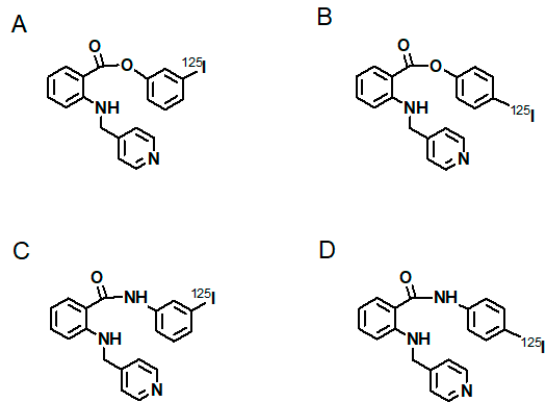
Figure 7. AAL 993-based VEGFR imaging agents; ( A ): [ 125 I] m -I-NPAE [269]; ( B ): [ 125 I] p -I-NPAE [269]; ( C ): [ 125 I] m -I-NPAM [269]; ( D ): [ 125 I] p -I-NPAM [269].